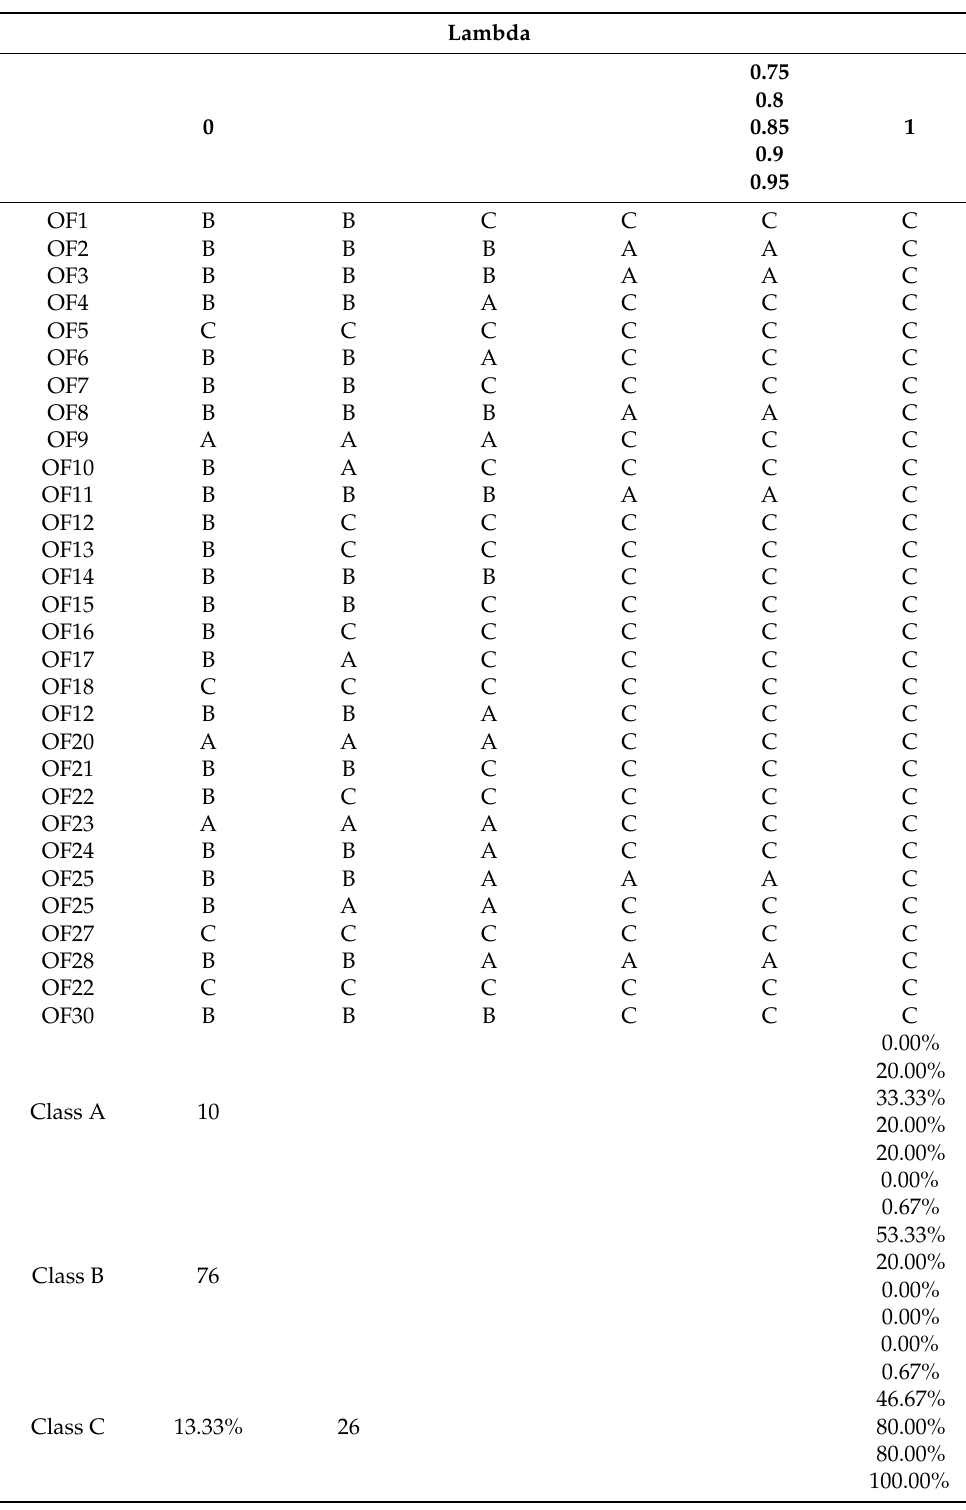
Table 13. Sensitivity analysis of the result, varying the cut-off